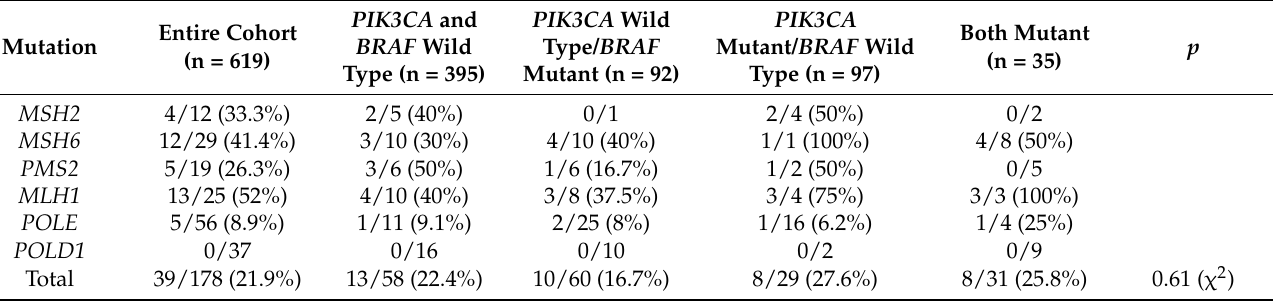
Table 8. Prevalence of functionally annotated mutations as oncogenic/probably oncogenic of MMR and proof-reading polymerases associated genes in the DFCI cohort. The nominator in each case represents number of oncogenic or probably oncogenic mutations and the denominator represents the total number of mutations of each gene in each